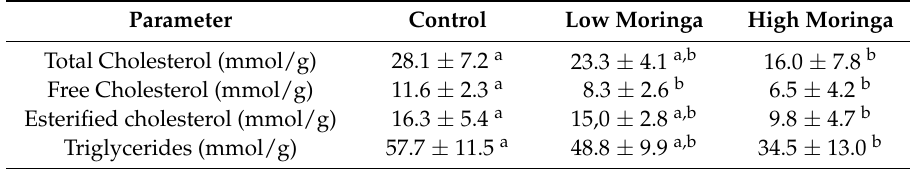
1 Values are means ± SD, n = 8; Values in the same row with different superscripts a and b are significantly different at p < 0.05.